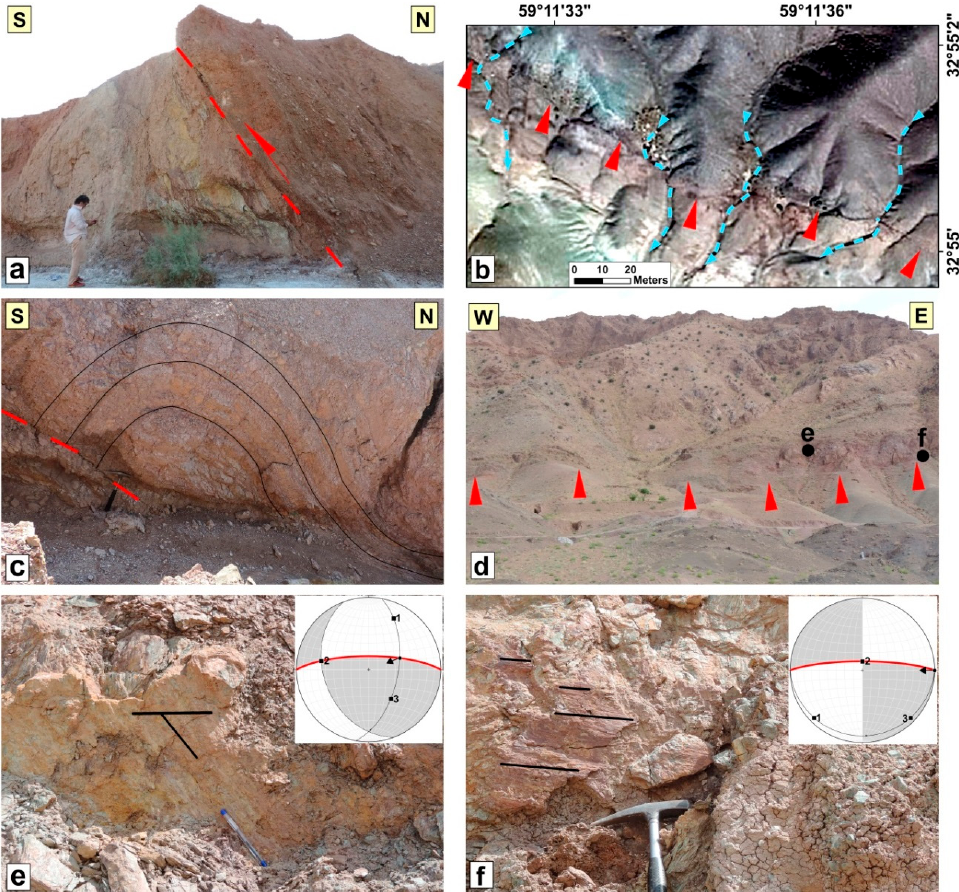
Figure 11. ( a ) The NBF with attitude of ~N90°E, 65°N. ( b , c ) Google Earth image of the stream deflection and field image of the fault-propagation folds along of the North Birjand fault. ( d ) The trace of the Shekarab fault in the eastern part of its length. ( e , f ) Close-up views of the Shekarab fault (N90°E, 75°N; 070°/52°- N90°E, 80°N; 090°/00°) among the Eocene volcanic rocks.